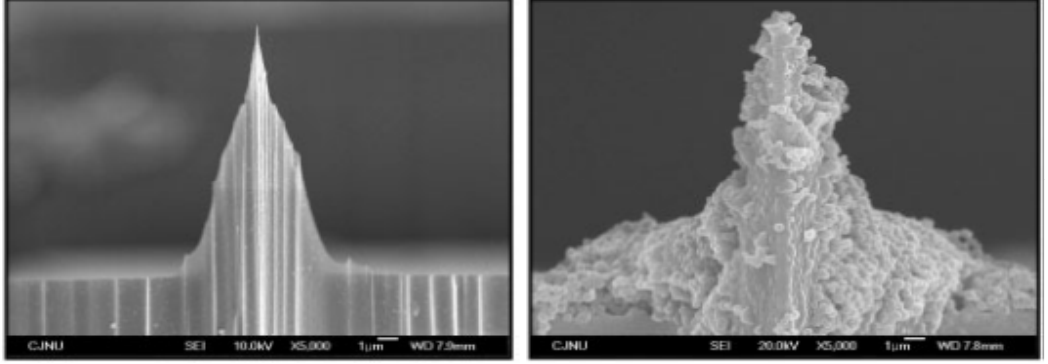
Figure 1. SEM images of a SiO /SiOH-based tip before (left) and after (right) grafting of 2 pMeOx on the surface (for details, see reference